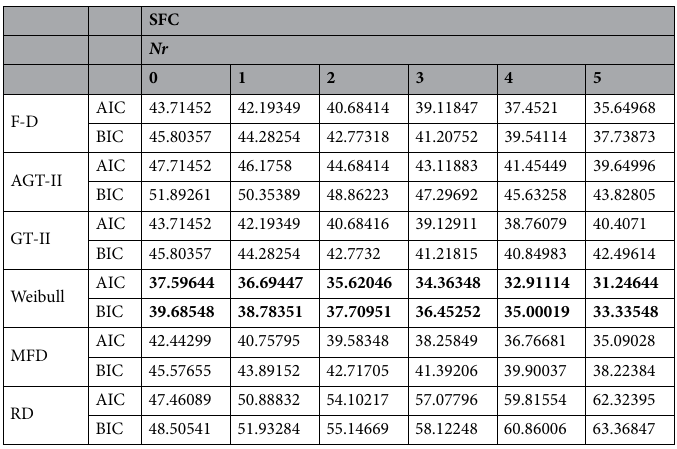
Table 5. Akaike information criteria (AIC) and (BIC) for SFC.